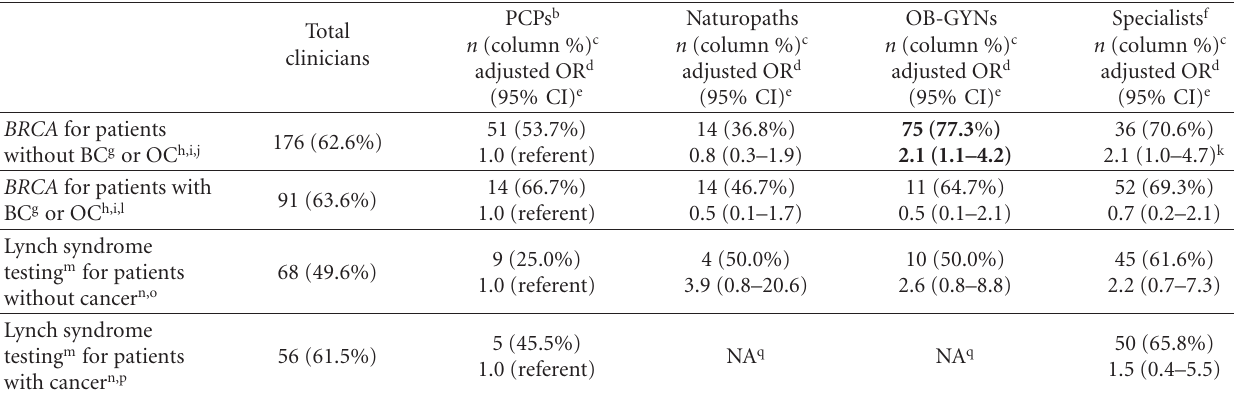
Table 3: Likelihood that clinicians reported ordering or recommending specific cancer genomic test in the past 12 months , by provider